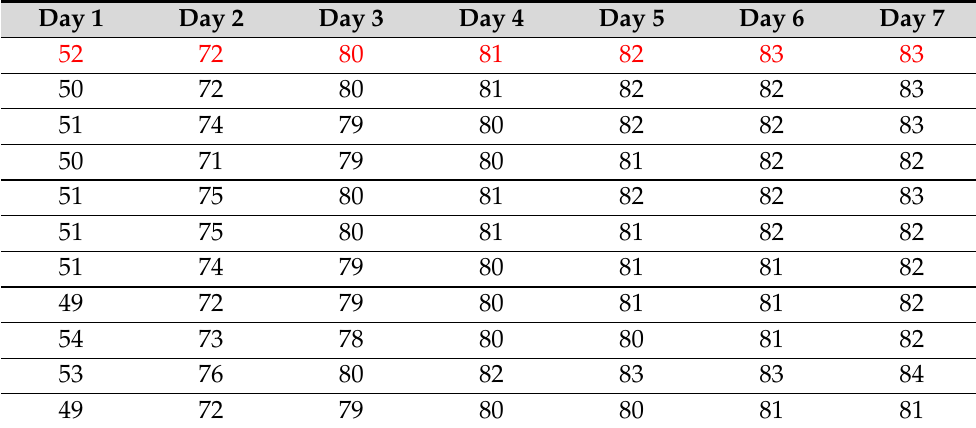
Table 2. Maximum level of characters who have high similarity of growth speed.